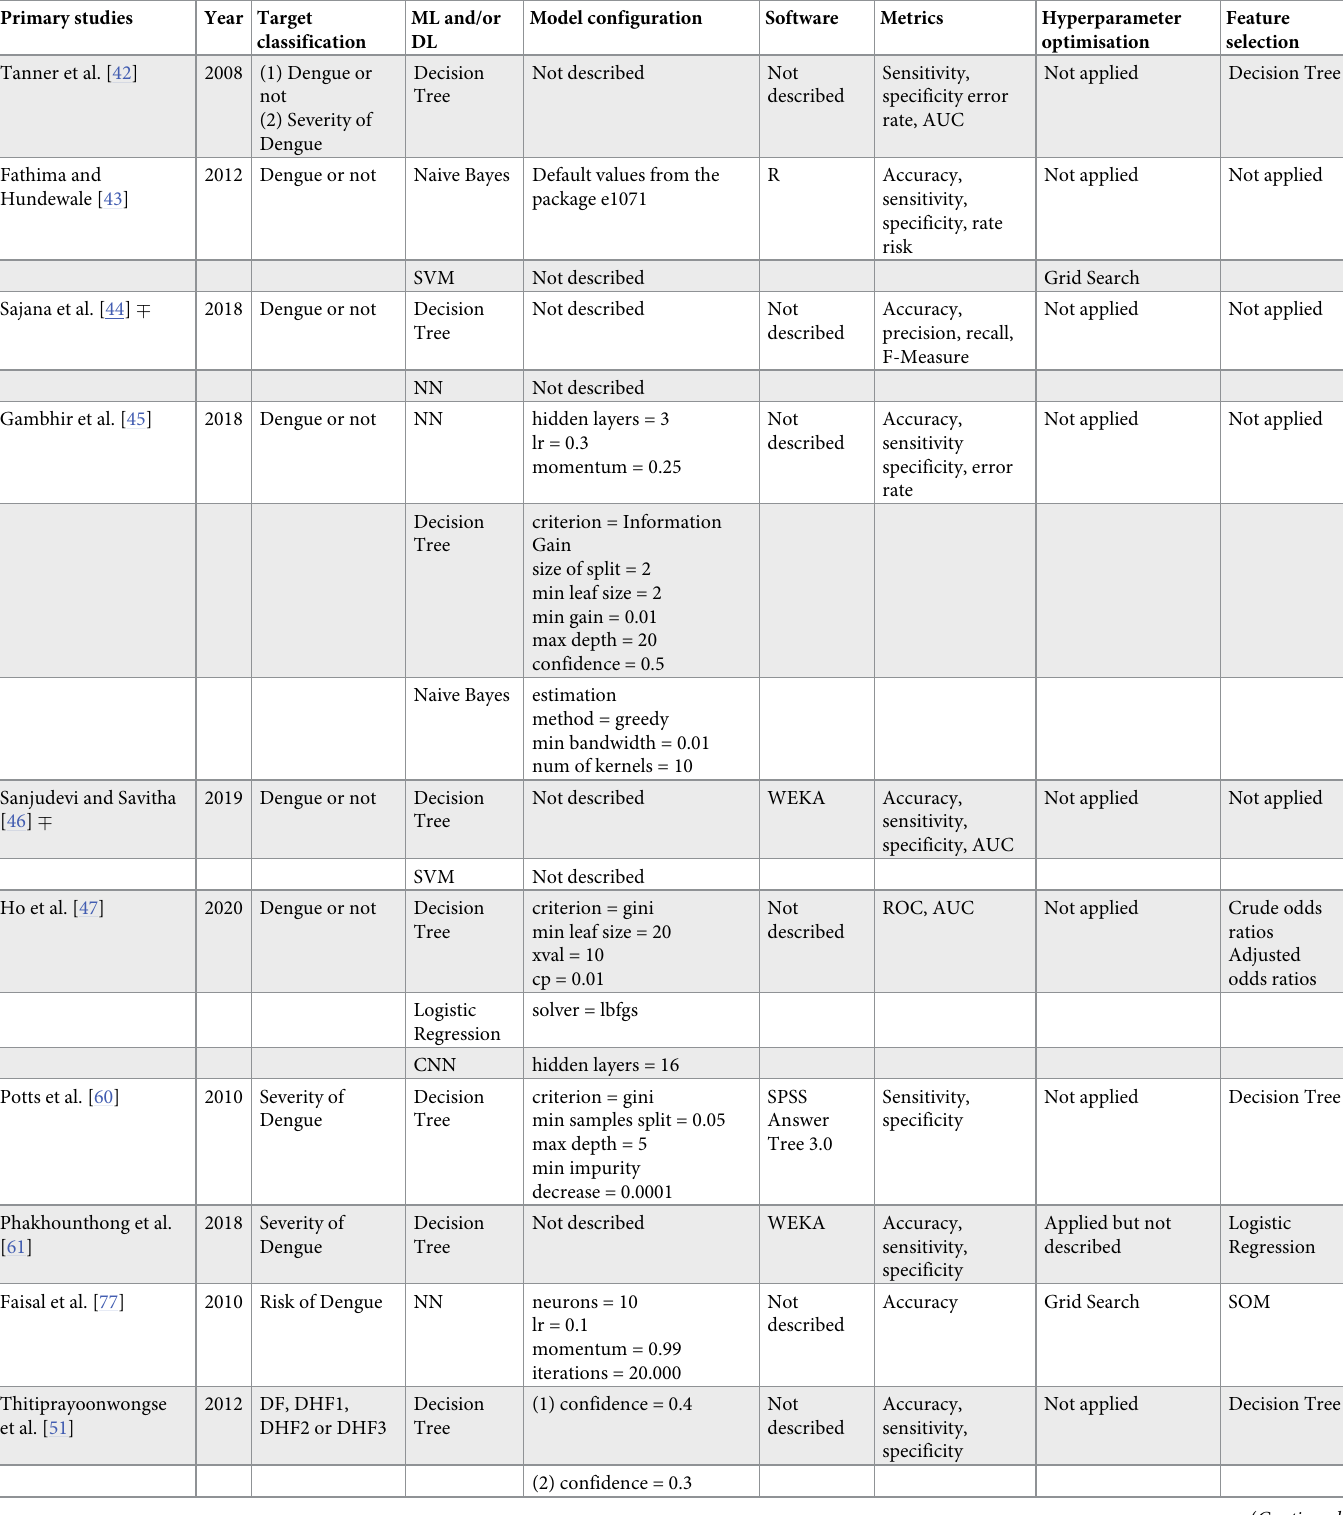
Table 1. Overview of the primary studies. � : The study seems to present a model overfitting or an inappropriate benchmarking methodology. Primary